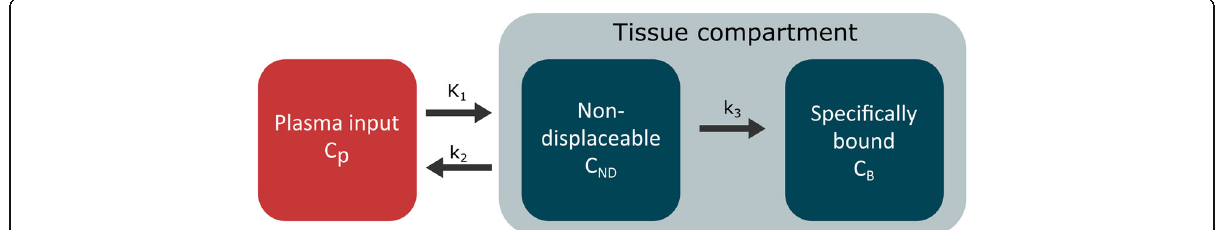
Fig. 1 Two-tissue compartment kinetic model used in the analysis of dynamic PET studies with 68 Ga-ABY-025 in patients with metastatic breast cancer. K 1 , k 2 , and k 3 represent the transfer rate